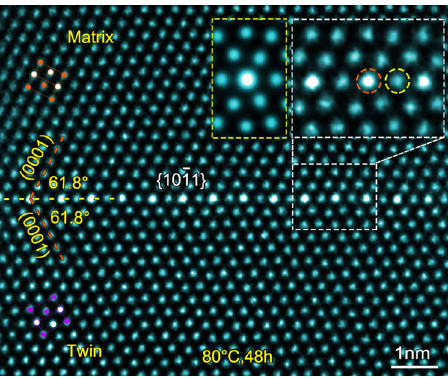
Fig. 1 Periodic segregation of Bi atoms in {1011} CTB. HAADF-STEM image showing a {1011} CTB in Mg – 0.4Bi alloy. An enlarged CTB is shown in the upper-right inset, indicating Bi-rich columns at compression sites of {1011} CTB. A simulated HAADF image, with the foil thickness of 75 nm (measured by PACBED), is inserted and enclosed by a yellow dotted-line rectangular frame. Periodical distribution of compression and extension sites in the CTB are marked by orange and yellow dash-line circles, respectively. Electron beam direction is parallel to